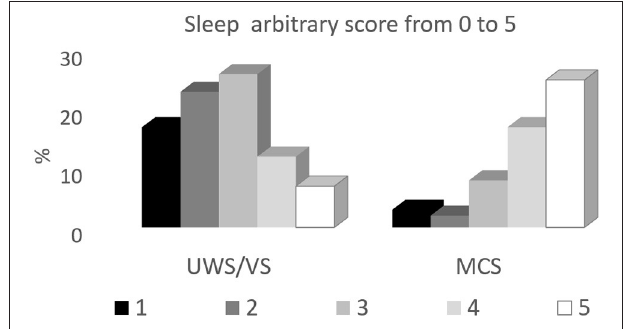
FIGURE 2 | Distribution of the different EEG patterns during behavioral sleep in UWS/VS and MCS patients. The sleep patterns are expressed in percentages with respect to each subgroup, according to the etiology of brain damage (ABI, anoxic brain damage; others, traumatic or vascular brain